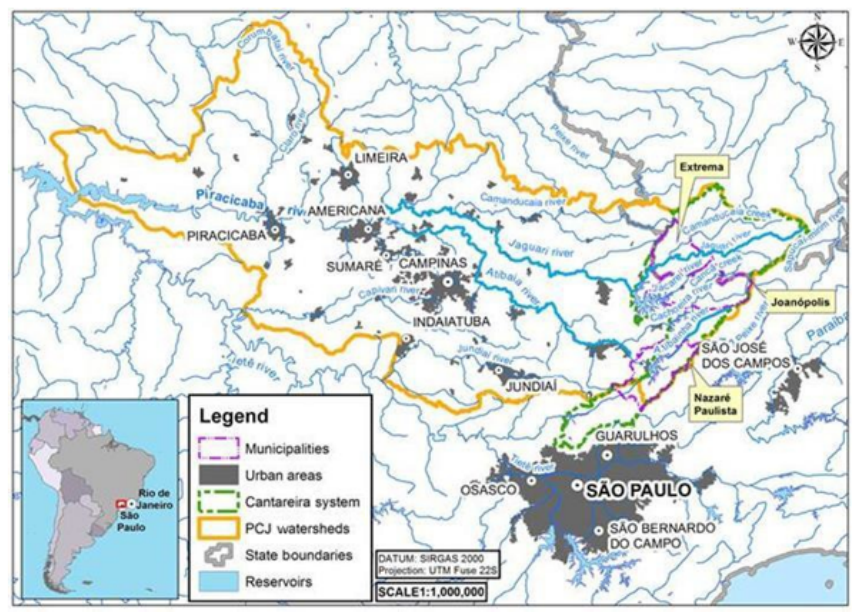
Figure 1. Location of the Cantareira water supply system in the Piracicaba and upper Tietê watersheds.